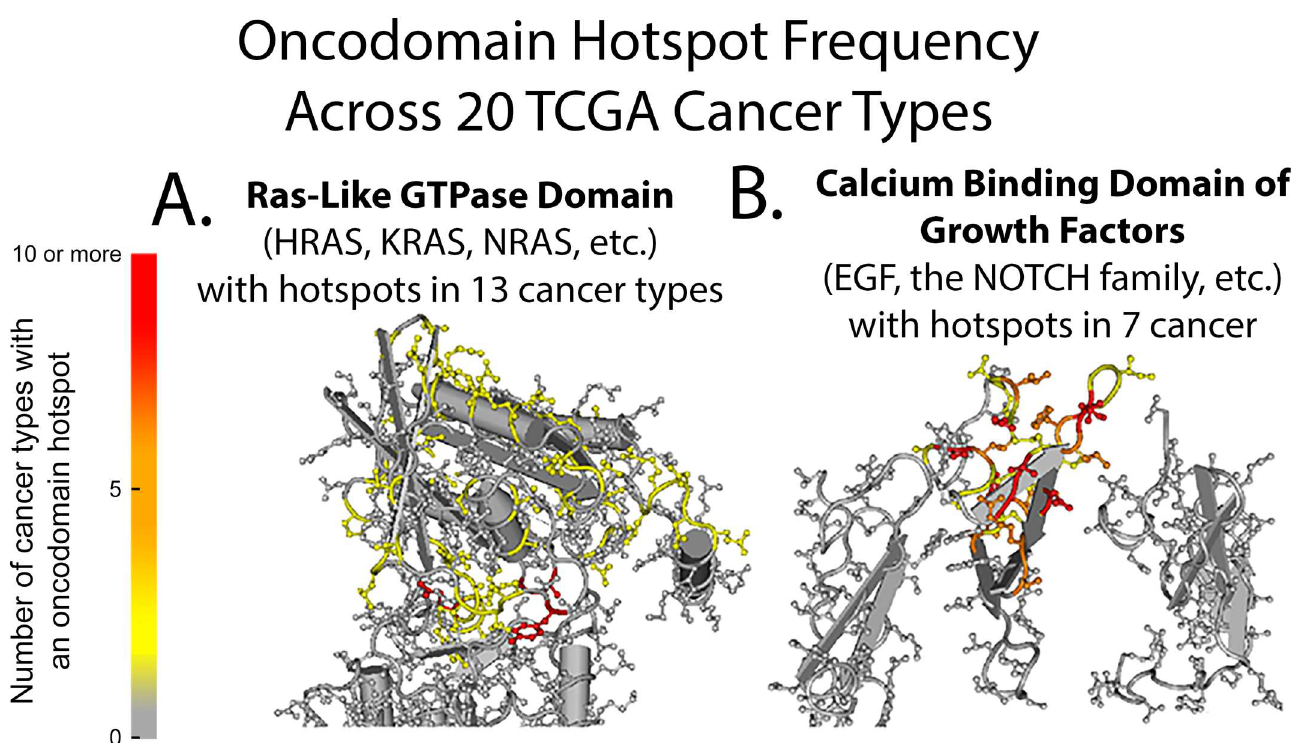
Fig 2. Hotspot frequency of the Ras-like GTPase oncodomain and the calcium binding Epidermal Growth Factor domain. Structural representations of the Ras-likeGTPase (cd00882) oncodomain family (A) and the calcium bindingdomainof the epidermal growth factor-like (cd00054)oncodomain family (B).